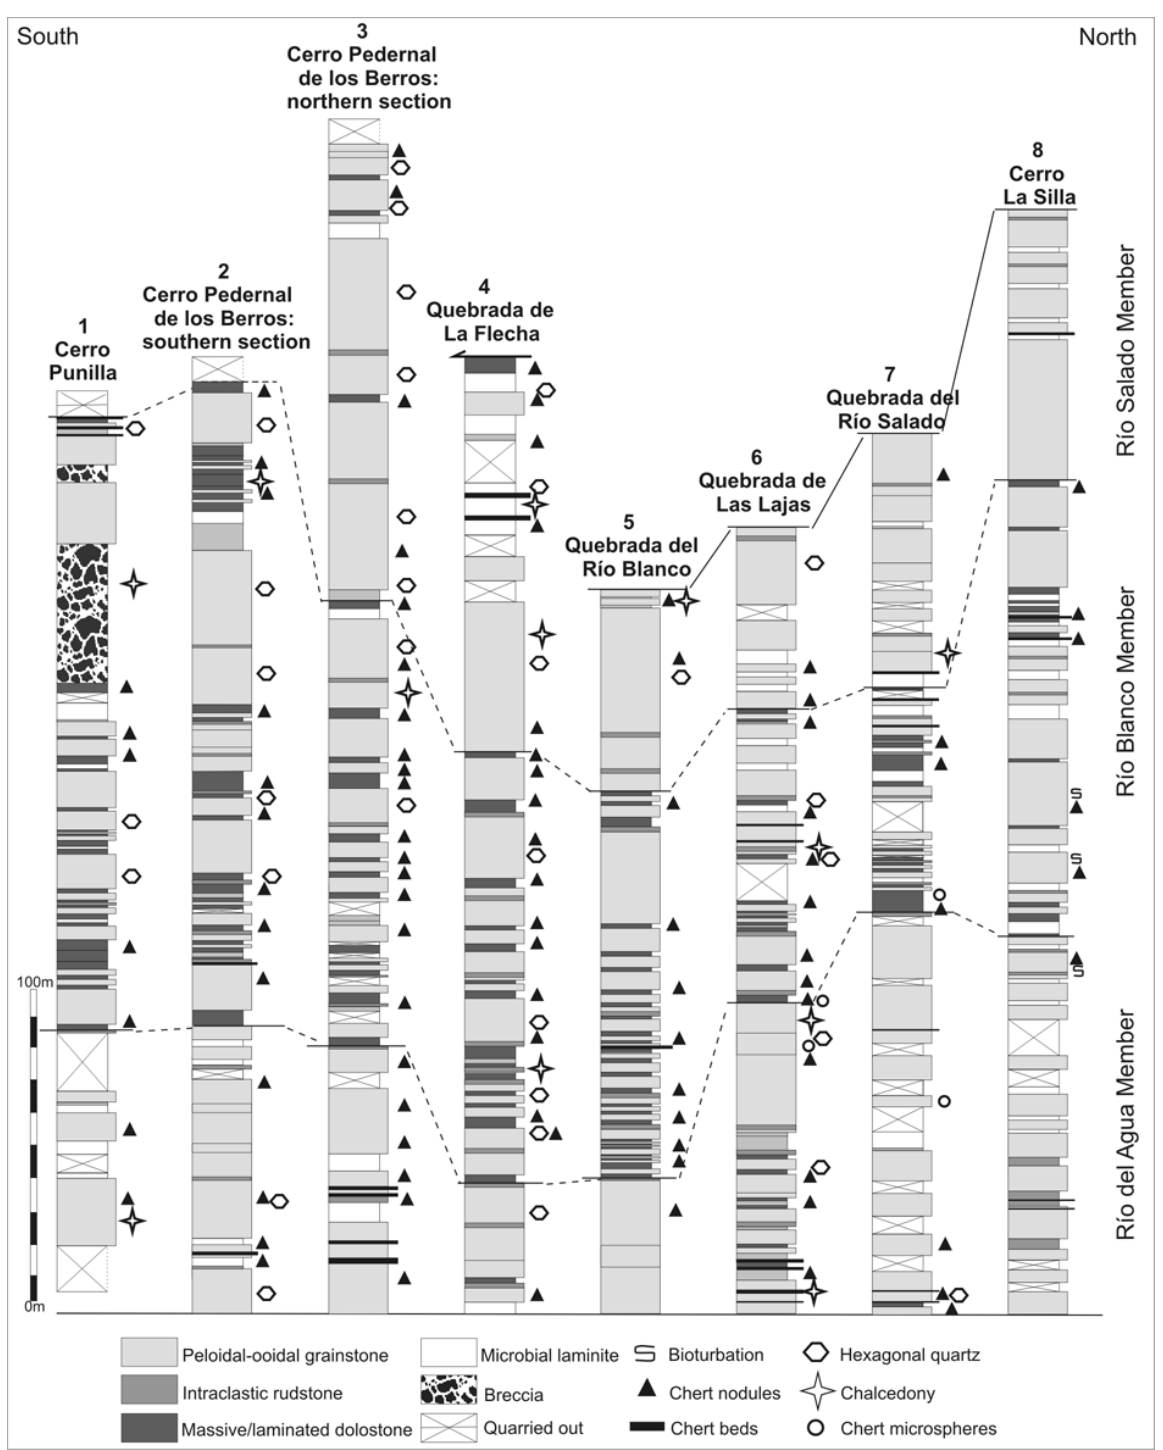
Fig. 2 – Lithological logs of the eight measured sections showing approximate distribution of lithofacies. The base is the contact between La Flecha and La Silla Formations (inferred at locality 1 where it is not exposed). The contact with the overlying San Juan Formation is corre- lated between localities 5 to 8 where it is exposed. Different types of chert are represented by